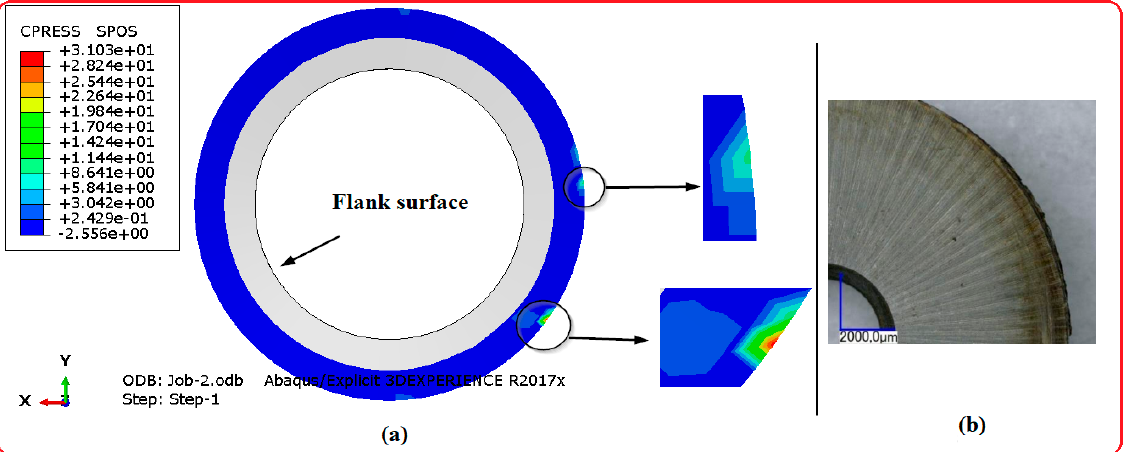
Figure 7. Topographical analysis of the adhesive strip on the flank surface of the saw blade (23,000 rpm, 200 mm/min): ( a ) numerical result; ( b ) experimental result.